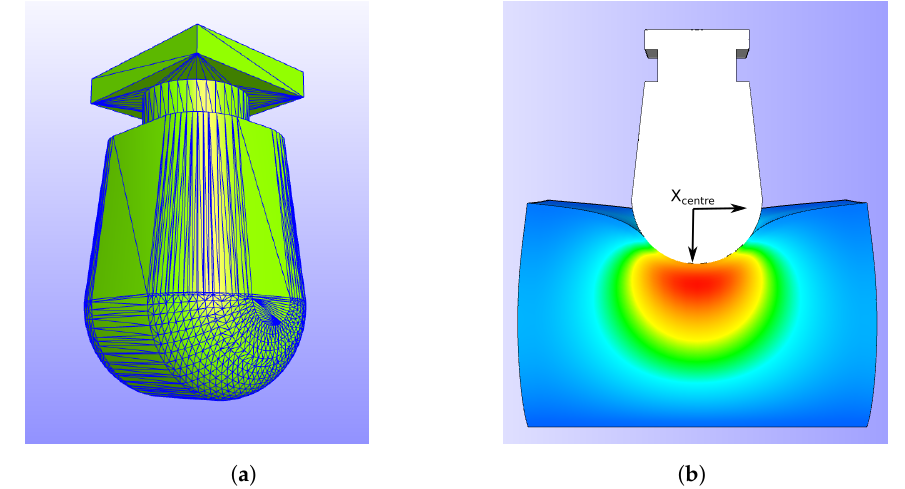
Figure 1. Figures of the simulation in FEBio. ( a ) 3D scan of Toshiba probe used in this study, and ( b ) sample indentation frame with the centre of the probe